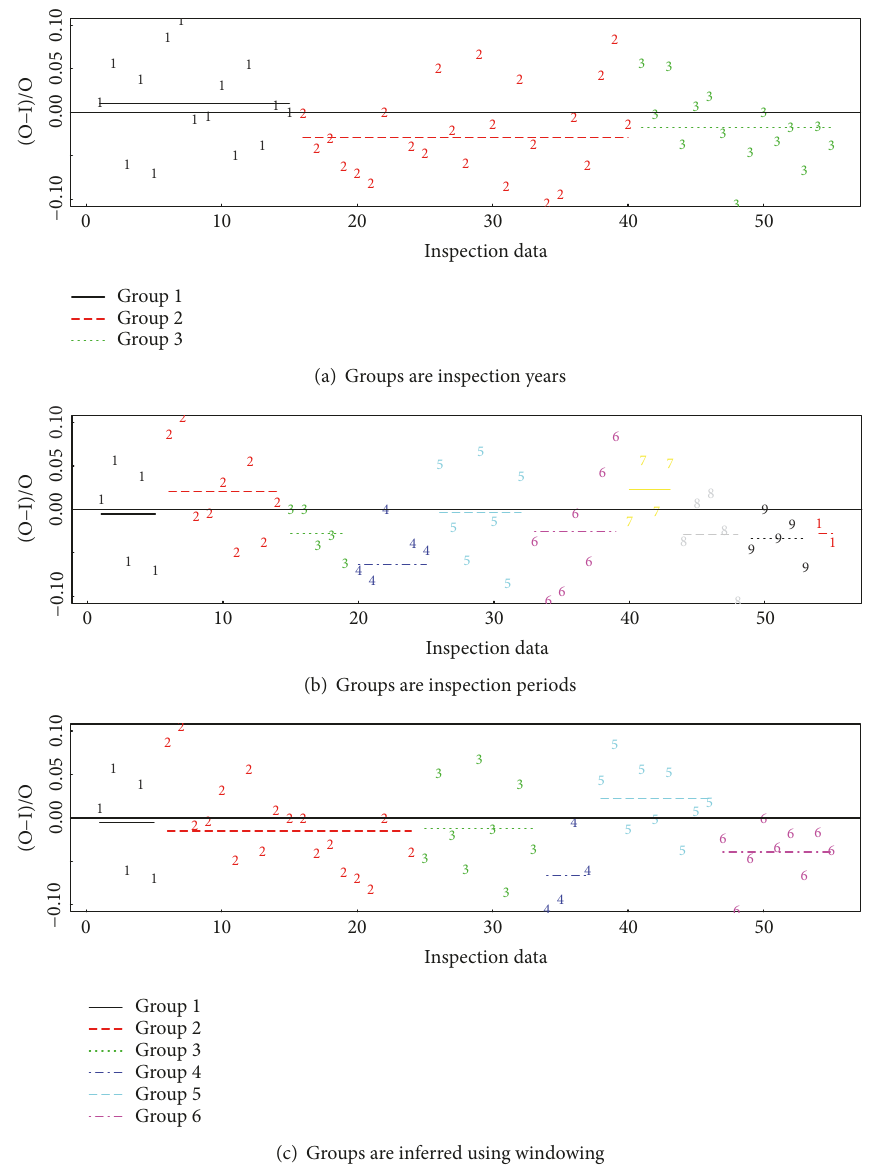
Figure 9: Real (O-I)/O data with the groups being the inspection years in (a), inspection periods in (b) (with multiple inspection periods per year), and the groups being inferred using windowing in